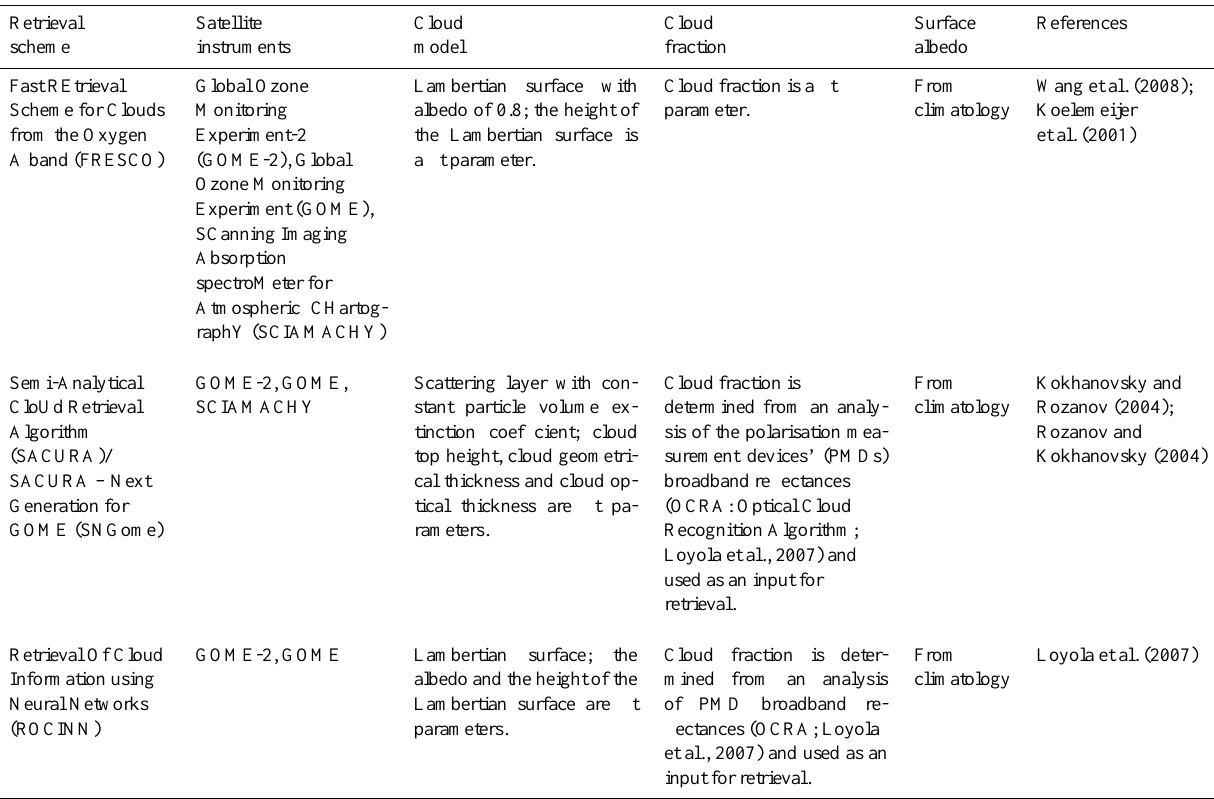
Table 1. Characteristics of operational satellite cloud retrieval schemes using spectral measurements of the O 2 A band. Retrieval